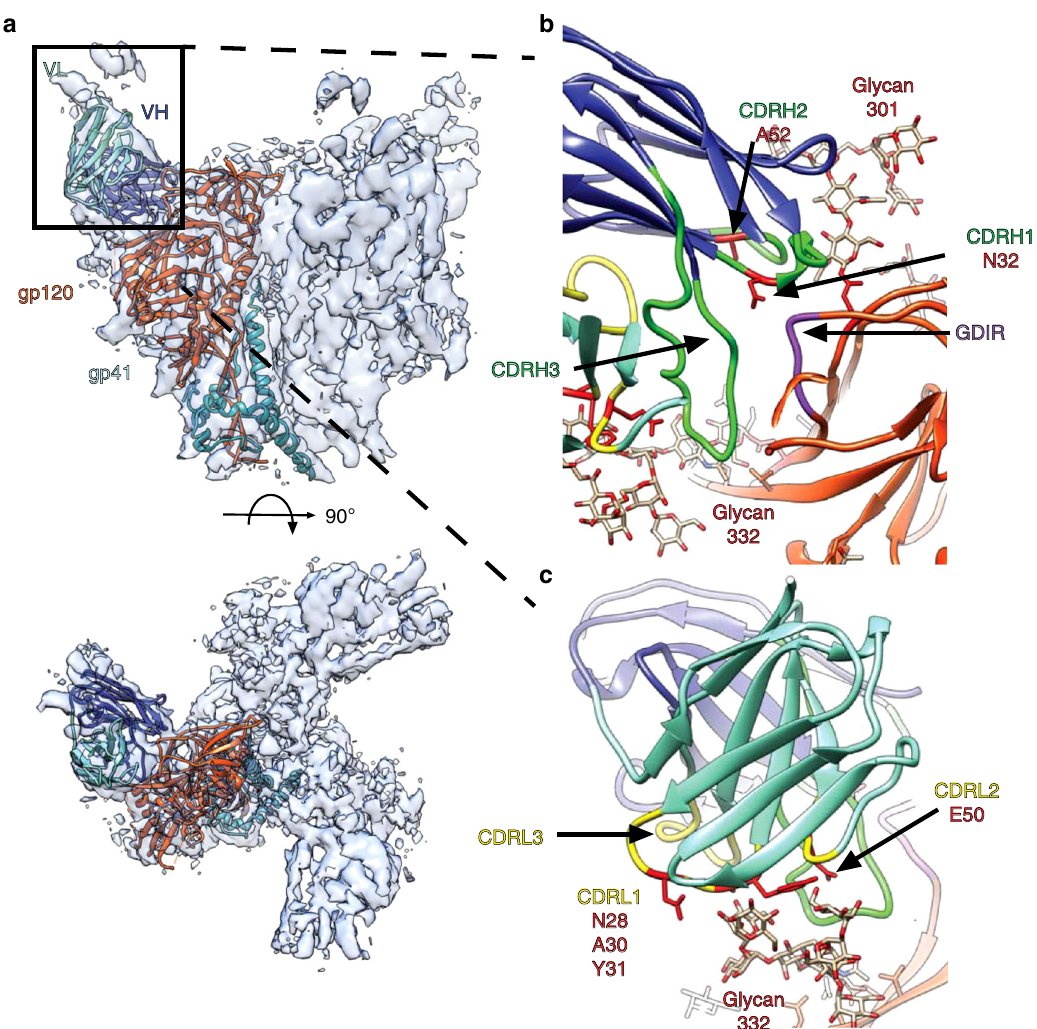
Fig. 4 Cryo-EM reconstruction and model of the BG505.SOSIP.664 trimer in complex with BF520.1 Fab. a Side (above) and top (below) views of the cryo- EM reconstruction and structural model. A single monomer consisting of gp120 (orange) and gp41 (dark cyan), and the BF520.1-Fv variable heavy chain (dark blue) and variable light chain (aquamarine) are highlighted. Glycans removed for clarity. The BG505.SOSIP trimer structure 5ACO.pdb docked into the new EM density map with a correlation score of 0.8602 34 . A global search yielded a preferred placement of the BF520.1 Fv model into the Fab density with a correlation score of 0.8513 (Supplementary Fig. 5g). b Expanded view of the VH domain and gp120. Shown are the conserved gp120 GDIR sequence (purple), glycans N332 and N301, and CDRH loops (green). Mutations that confer potent neutralization (red) are indicated. c Expanded view of the VL domain and the N332 glycan. CDRL loops (yellow) and mutations that conferred potent neutralization (red) are